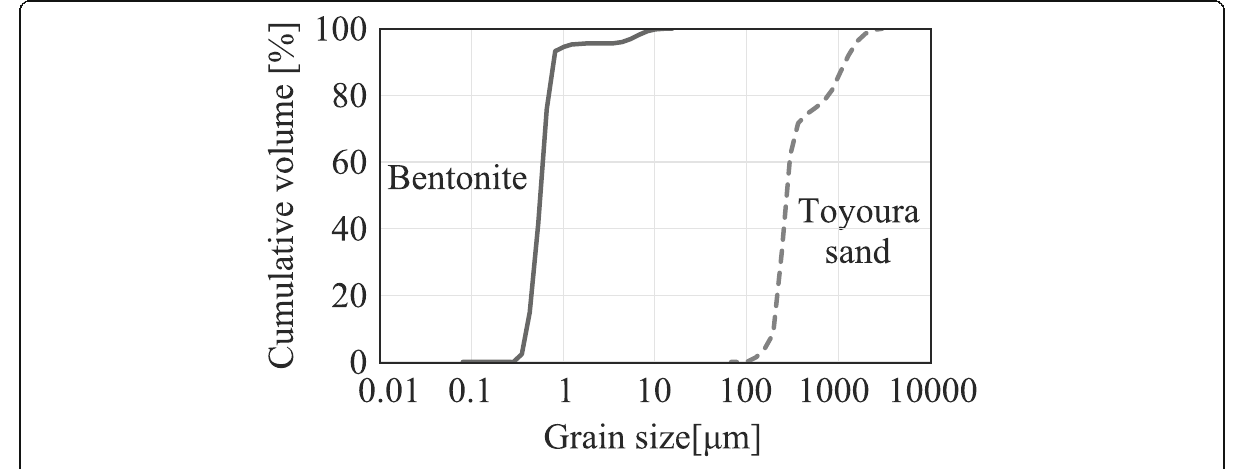
Fig. 5 Grain size accumulation curve for Toyoura sand and